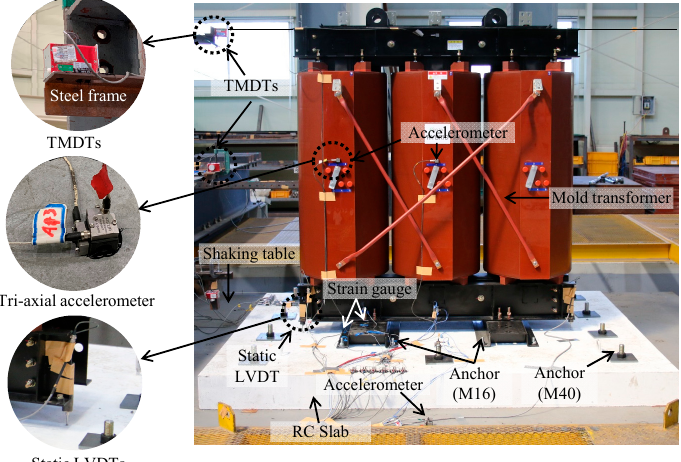
Figure 2. Schematic of test set-up and measurement instrumentation. LVDTs, linear variable displacement transducers: RC = reinforced concrete.